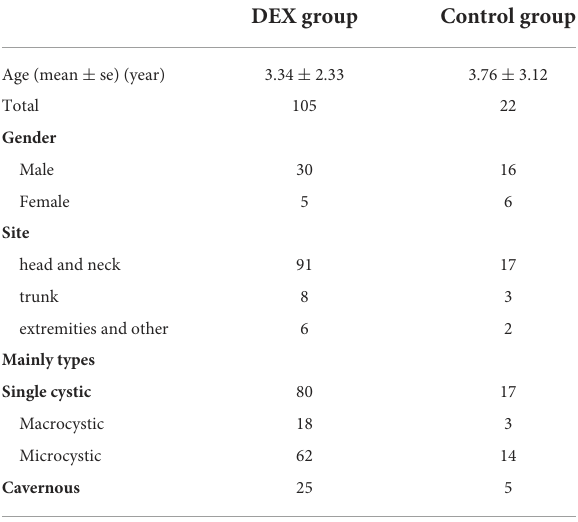
TABLE 1 The characteristics of the one hundred and twenty-seven patients. DEX group Control